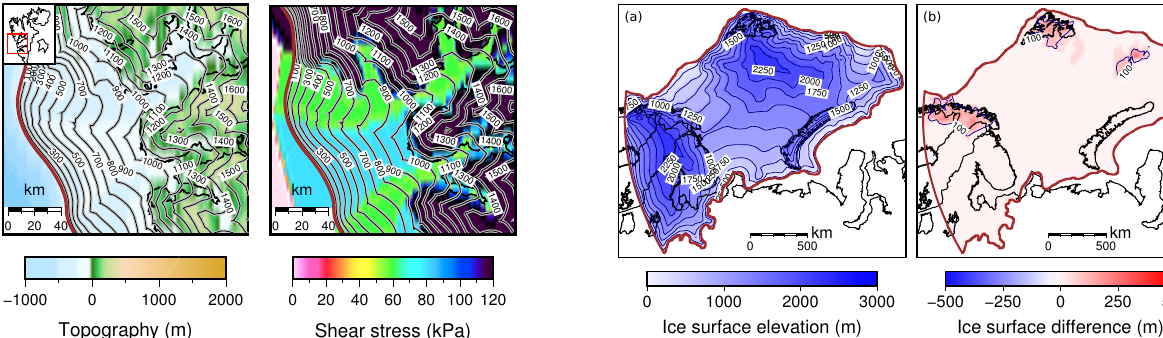
Figure 3. Example from central–western Svalbard of how spatial changes in basal topography and basal shear stress affect the re- constructed ice surface topography of the ice sheet (see text). The contour interval is 100m in the figure, though this sample was cal- culated with a 5km spacing and 20m contour interval. The dark black lines are the modern-day coastlines.